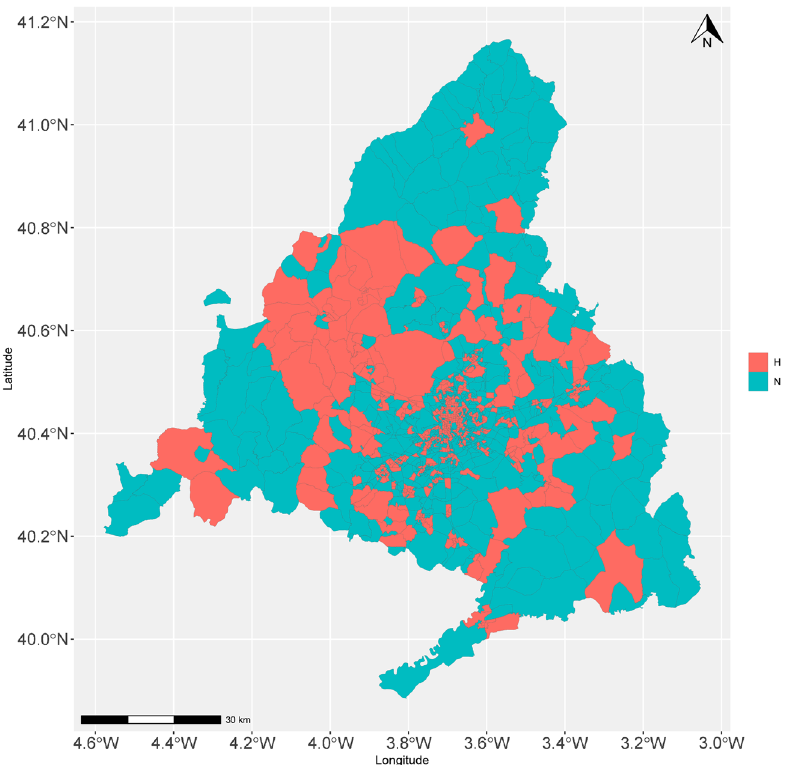
Figure 4. Map categorising the zones per origin. Information retrieved from 34 was utilised for the construction of the map.